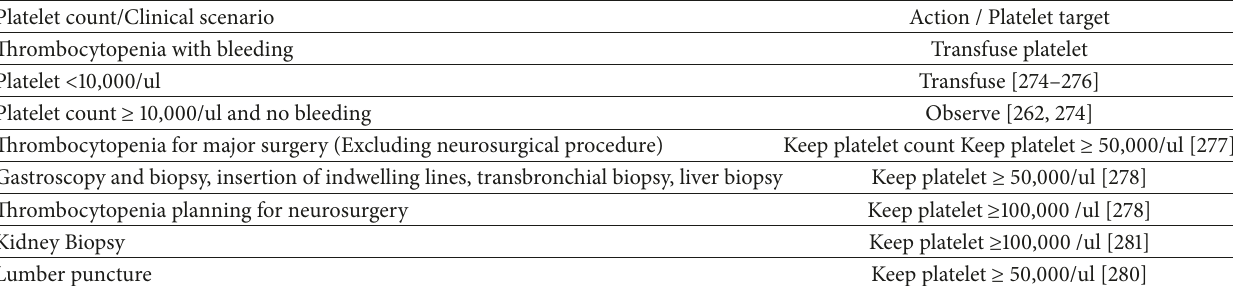
Table 3: Indications for platelet transfusion in